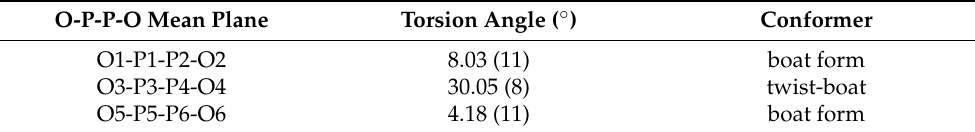
Figure 5. Boat and twist-boat conformers of the metallacycles in complex 1 . Table 1. Mean planes and torsion angles of the metallacycle rings in complex 1.